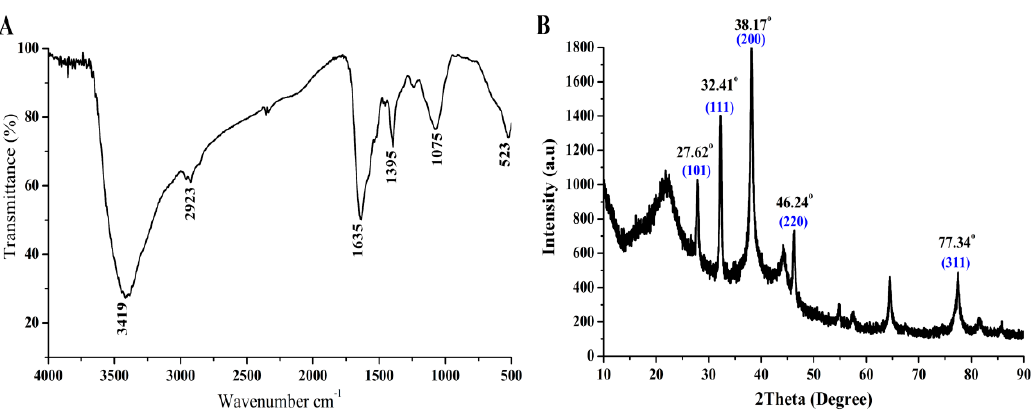
Figure 8. Characterization of the biosynthesized AgNPs after four days of incubation. ( A ): Fourier-transform infrared spectrum of biosynthesized AgNPs. ( B ): X-ray diffraction patterns of the biosynthesized AgNPs.